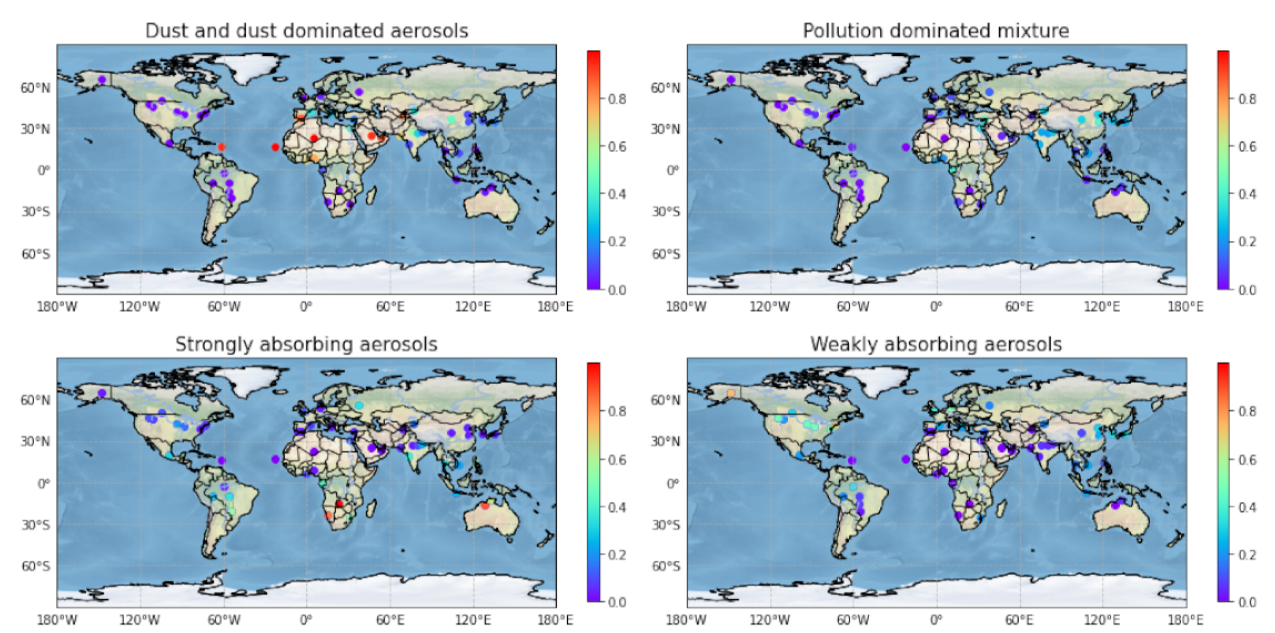
Figure 3. Spatial distribution of four kinds of aerosol. The color dot in each station implies the values of occurrence frequency in the color